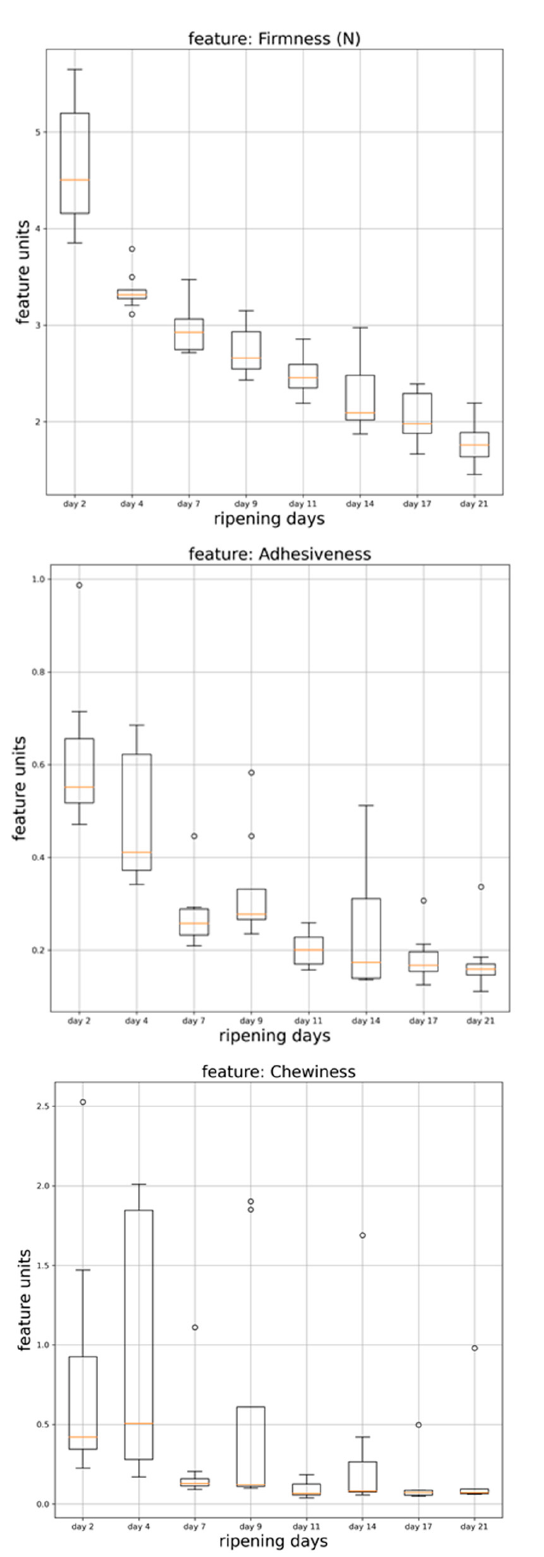
Figure 7. Firmness, springiness, adhesiveness, cohesiveness, and chewiness of the banana-flesh samples during storage, at 18.0 ± 0.5 °C. samples during storage, at 18.0 ± 0.5 ◦